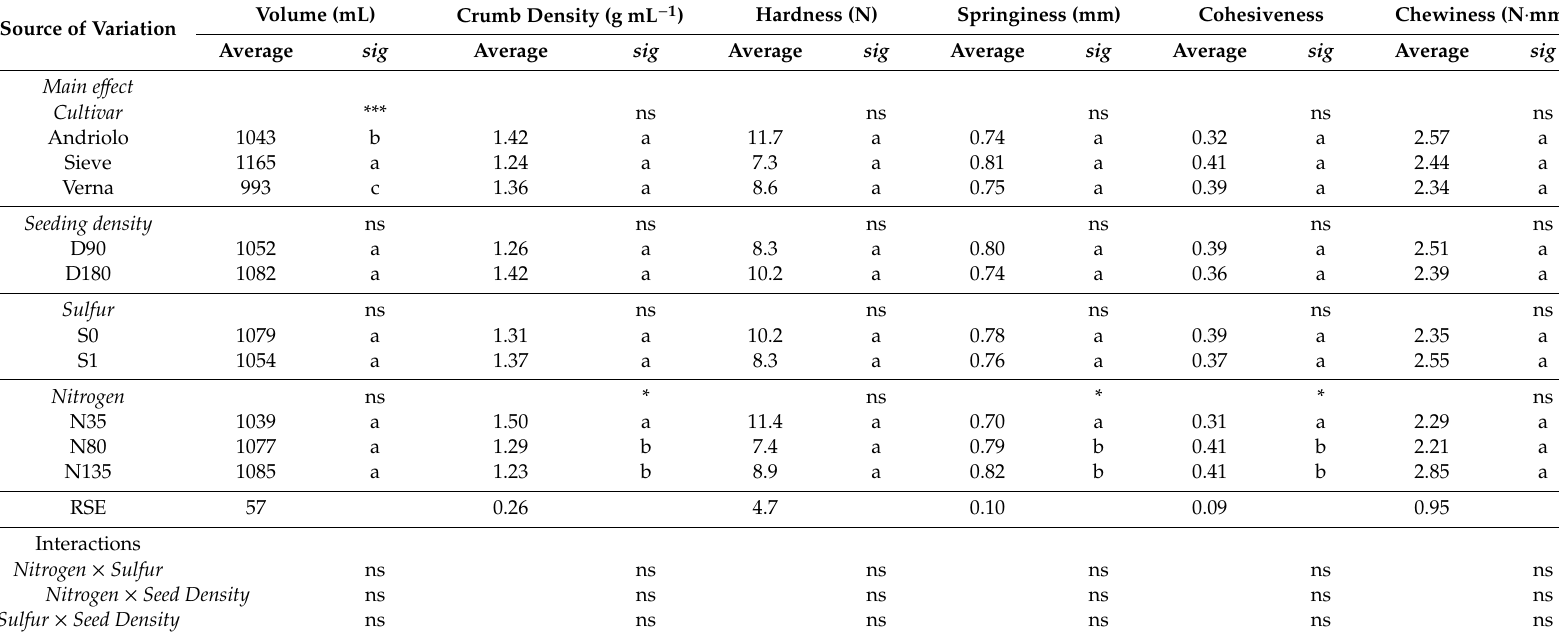
Table 4. Mean of quality analyses on breads shown by nitrogen fertilization, sulfur fertilization, seed density, cultivar and first order interaction. The sig columns report the ANOVA results (* = 0.05, ** = 0.01, *** = 0.001, ns = not significant), while lowercase letters represent the Tukey HSD post hoc test results. RSE = residual standard